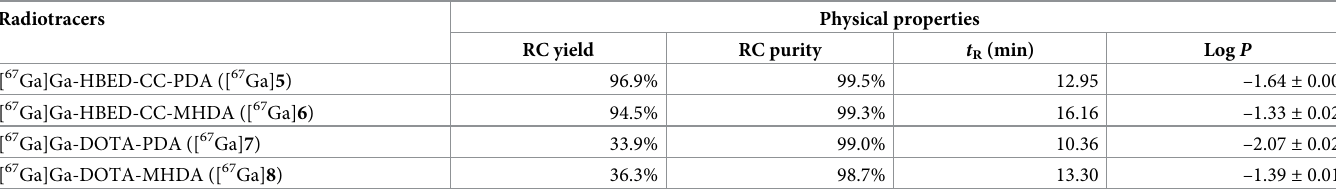
Table 1. Physical properties for radiogallium complex conjugated fatty acid